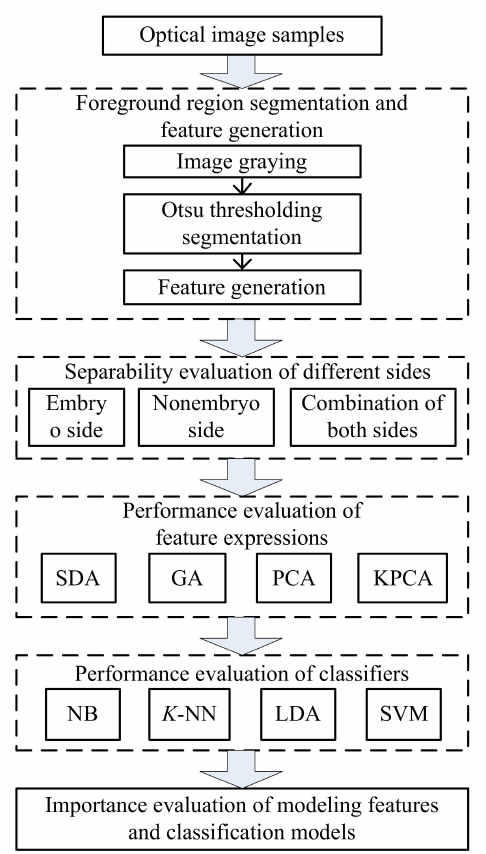
Figure 3. Flow diagram of the performance evaluation for cultivar classifications of sweet corn seeds based on optical images. SDA, KPCA, NB and K -NN represent stepwise discriminant analysis, kernel principal component analysis, naïve Bayes and K -nearest neighbor,